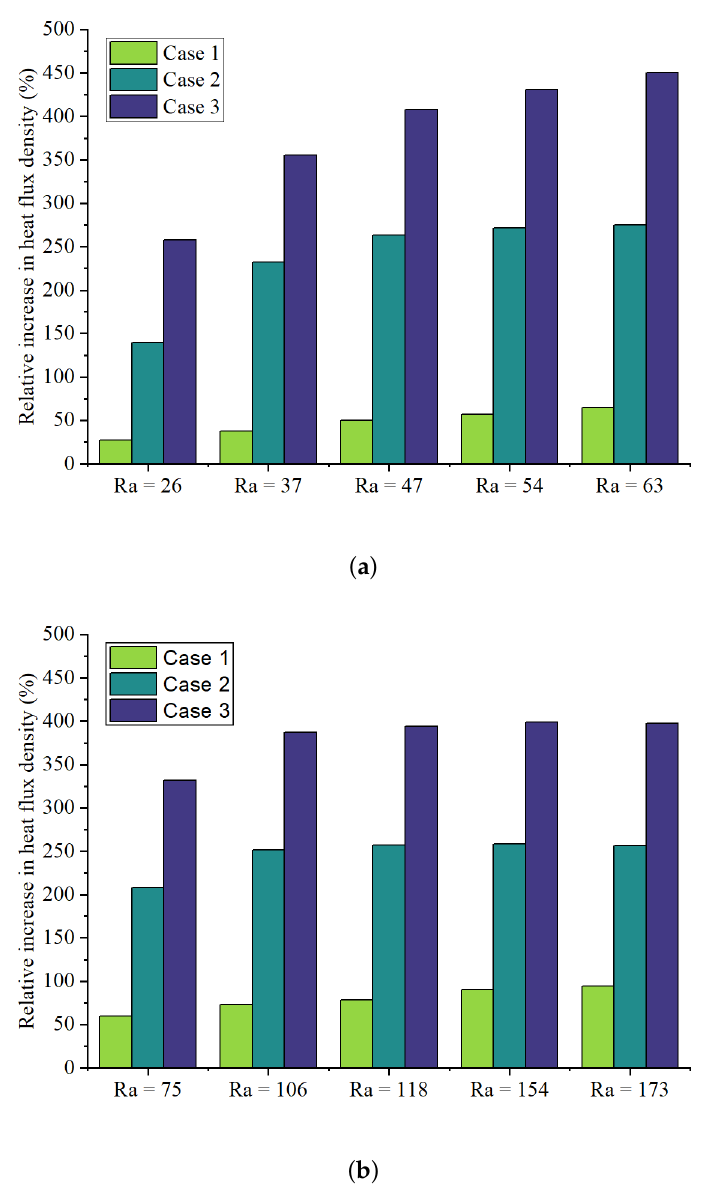
Figure 7. Relative increase in heat-flux density for the studied cases. ( a ) Heat exchanger no. 1. ( b ) Heat exchanger no.